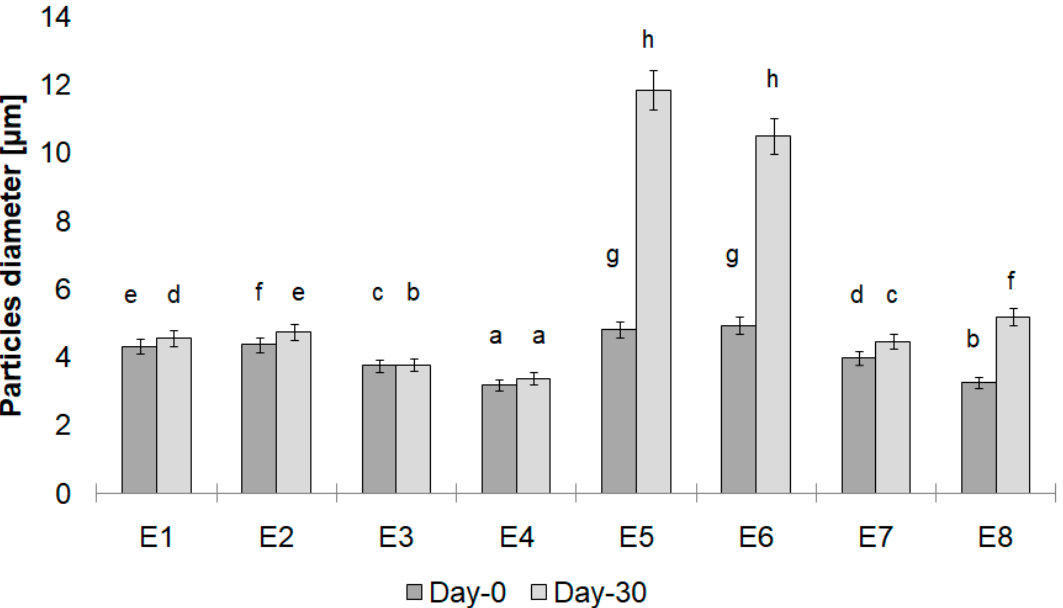
Figure 3. Particle size of emulsions. Day-0: measurement taken on the freshly prepared emulsions. Day-30: measurement taken on the emulsions stored 30 days at 30 °C. Different letters indicate statistically significant difference ( p < 0.05).